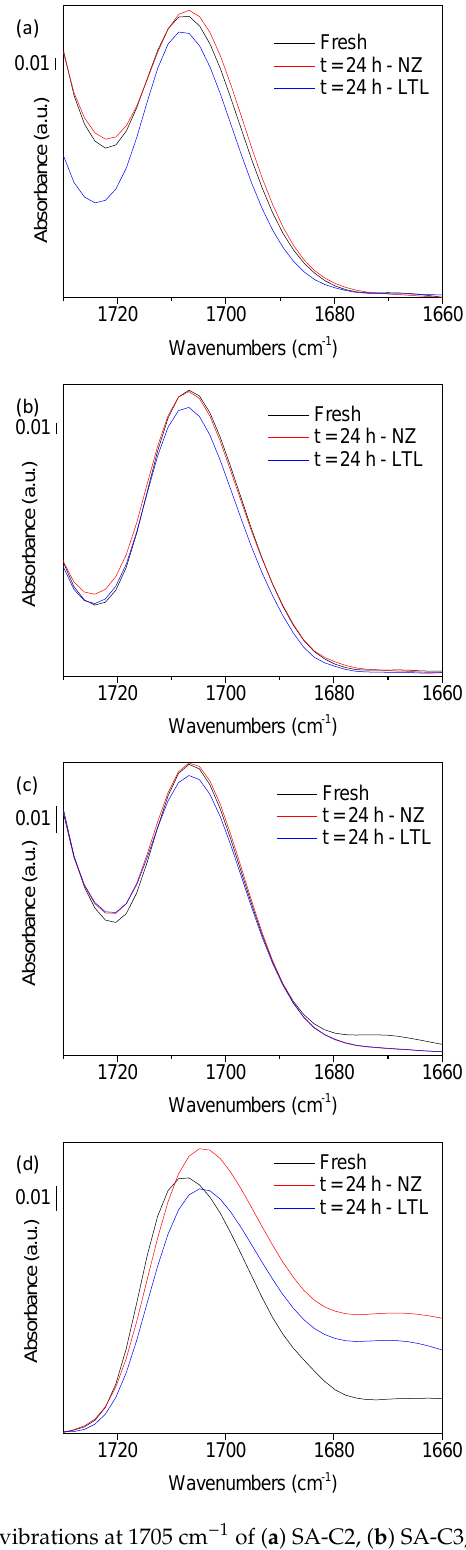
Figure 6. C=O FTIR band vibrations at 1705 cm − 1 of ( a ) SA-C2, ( b ) SA-C3, ( c ) SB-C2, and ( d ) SB-C3 in their fresh form (black) or following 24 h of oxidation at 150 °C in absence (red) or presence (blue) of LTL nanozeolite.